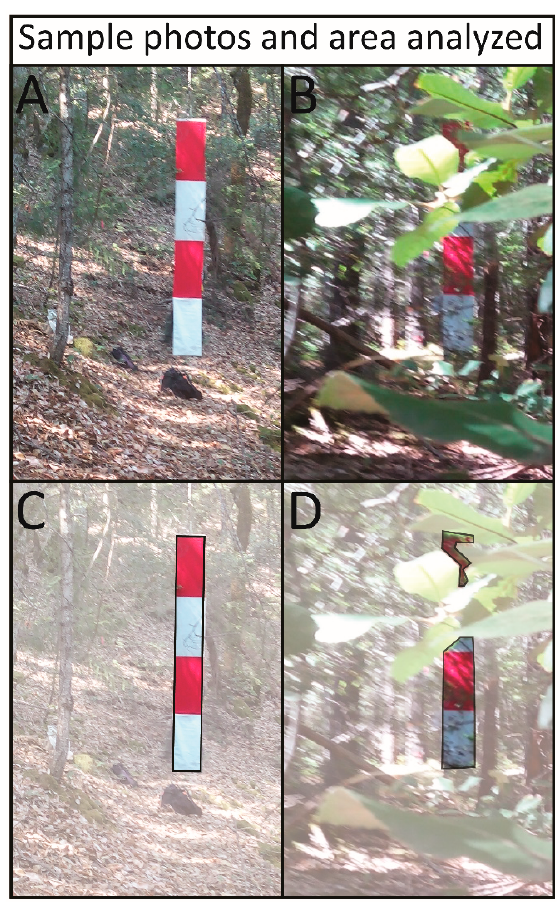
Figure 4. Examples of photos used to analyze ladder fuel cover ( A , B ); and their respective analysis boundaries ( C , D ). Areas left out of analysis are faded out in ( C , D ), whereas areas included in